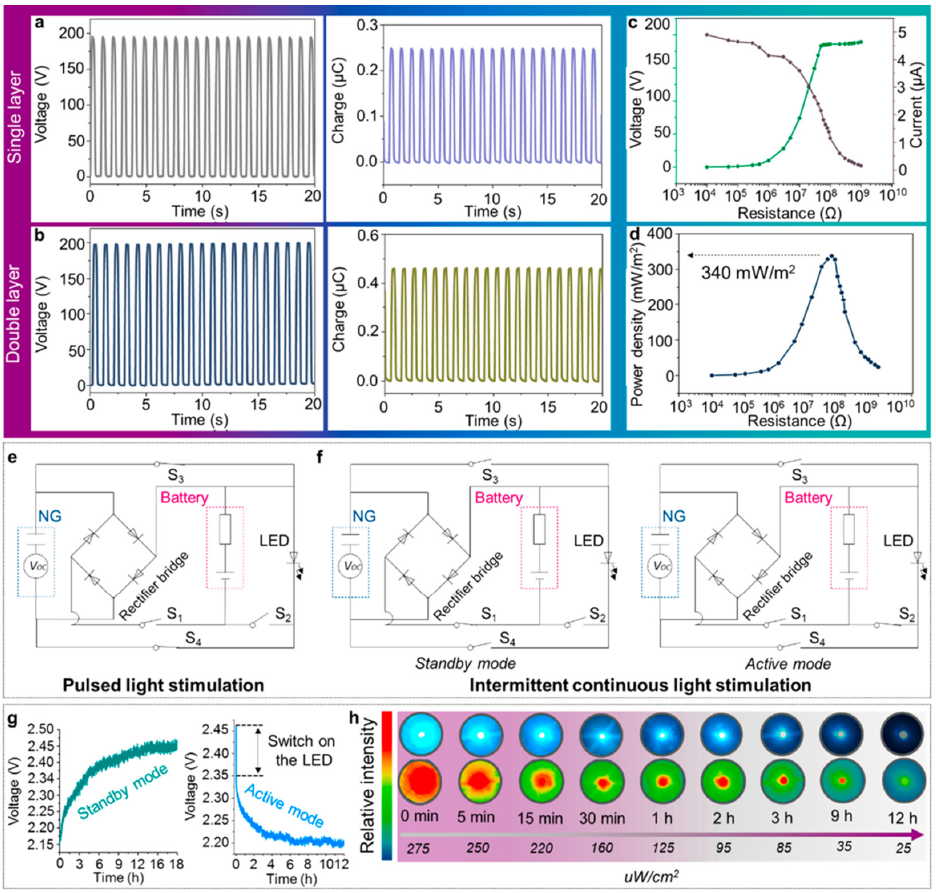
Figure 26. Performance of the ts-PENG designed by Liu et al. [113]. The open-circuit voltage and short-circuit transferred charge of the PENG with ( a ) single and ( b ) double PVDF film. ( c ) Voltage and current and ( d ) power density of the ts-PENG under different load resistances between 10 kΩ and 10 GΩ. ( e , f ) Schematic representation of the irradiation modes of PLS and ICLS. ( g ) Charging and discharging voltage of the button cell by the ts-PENG and LED, respectively. ( h ). Results of the light intensity of LED as a function of time. Reprinted with permission from [113]. Copyright 2020, American Chemical Society.